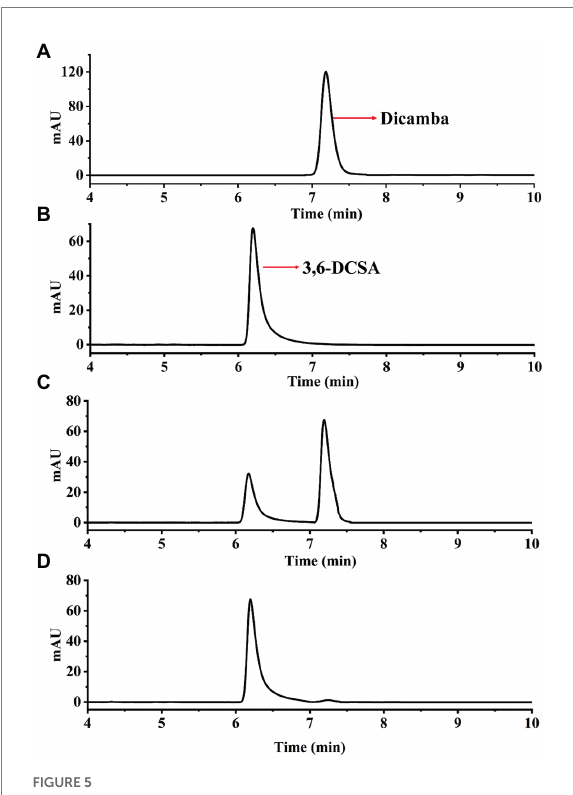
FIGURE 5 HPLC analysis of the product produced during dicamba conversion by Dmt06. (A) The dicamba standard. (B) The 3,6- DCSA standard. (C) Sample collected at 5 min. (D) Sample collected at 10 min.